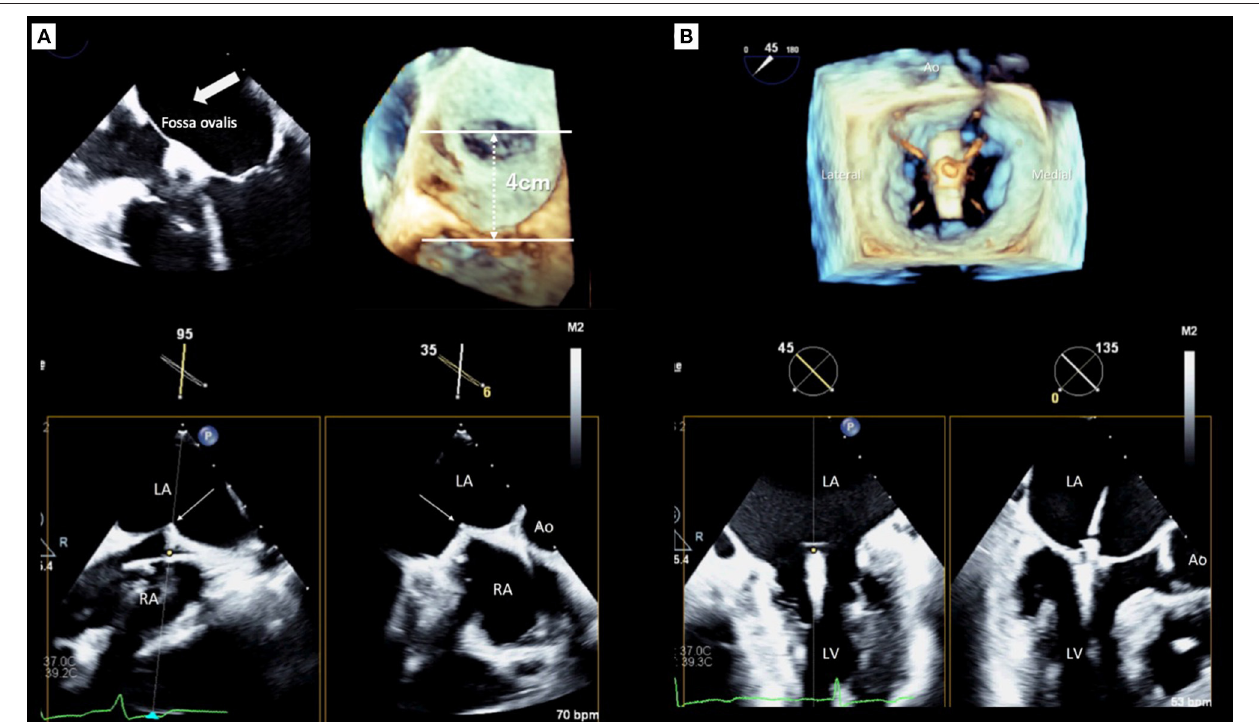
FIGURE 2 | Real-time guidance for MitraClip implantation using three-dimensional transesophageal echocardiography. (A) Transseptal puncture guidance, (B) Clip deployment. LA, left atrium; LV, left ventricle; Ao,